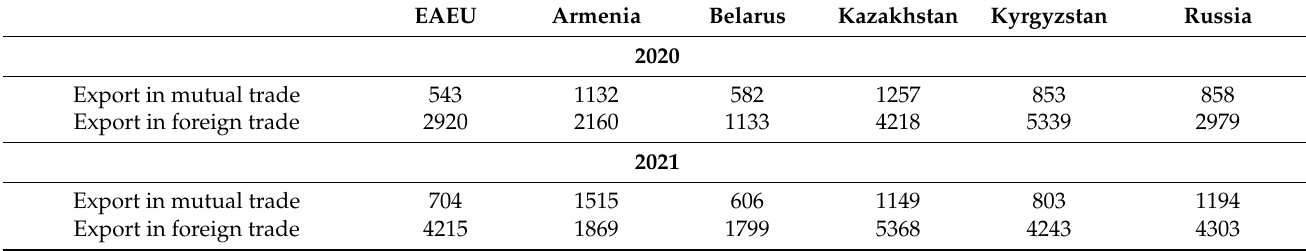
Table 3. Dynamics of the commodity concentration index (Herfindahl-Hirschman index) for the EAEU